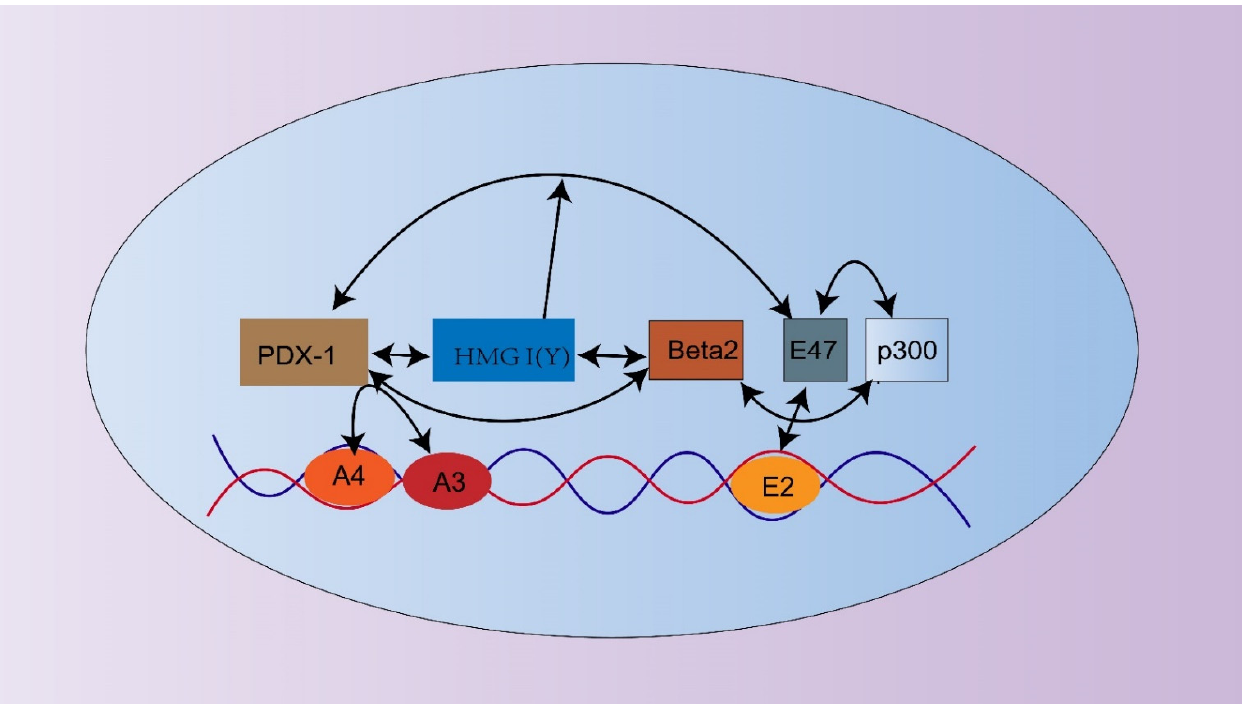
Figure 4. The regulation of insulin expression gene and formation of transcription activation complex. PDX-1 can bind to the A3 and A4 (collectively referred to as A3/4) sites and activate the E2A3/4 mini-enhancer by synergizing with E47 bound to the E2 site. PDX-1 and E47 do not activate the E2A3/4 mini-enhancer either individually or together. The addition of high-mobility group protein I(Y) (HMG I(Y)) allows for strong cooperative activation of the mini-enhancer by the three proteins together, but only if both the E and the A binding sites are intact in the mini- enhancer. Beta2 and HMG I(Y) contribute to PDX-1–E47 synergy through direct interactions with the homeodomain of PDX-1. The homeodomain of PDX-1 acts as a protein–protein interaction domain to recruit multiple proteins, including E47, Beta2, and HMG I(Y), to an activation complex on the E2A3/4 mini-enhancer. The p300 coactivator interacted with the activation domains of Beta2 and E47 both physically and